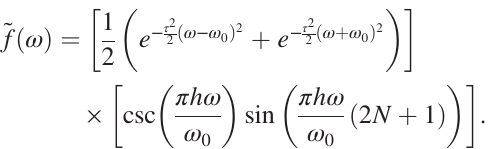
FIG. 2. An illustration of the longitudinal phase space dynam- ics involved in the generation of short pulses. The red vertical lines correspond to a width of 0.2 λ , corresponding to a L harmonic up-conversion factor h ¼ 5 . In panel (a) we see the beam initially modulated by 10 3 times the energy spread σ . In E panel (b) the beam has dispersed into the coherent radiation regime, and it leaves this regime at panel (c). After further dispersion, the beam is as in panel (d), and no longer efficiently radiates